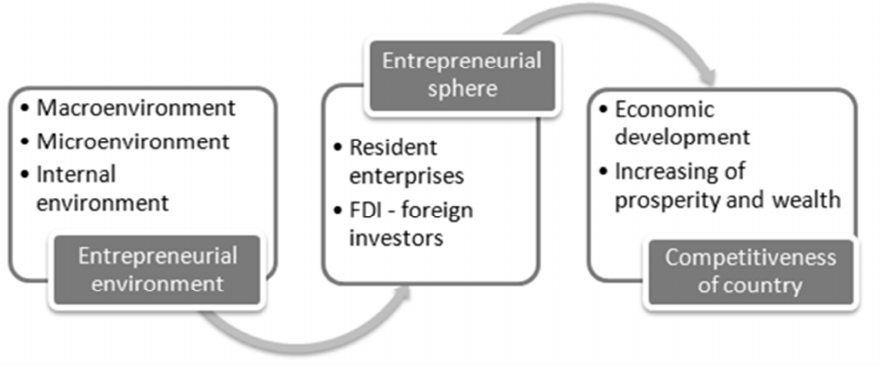
Figure 1 - Diagram of dependence "Entrepreneurial environment - FDI - Competitiveness" (Source: own